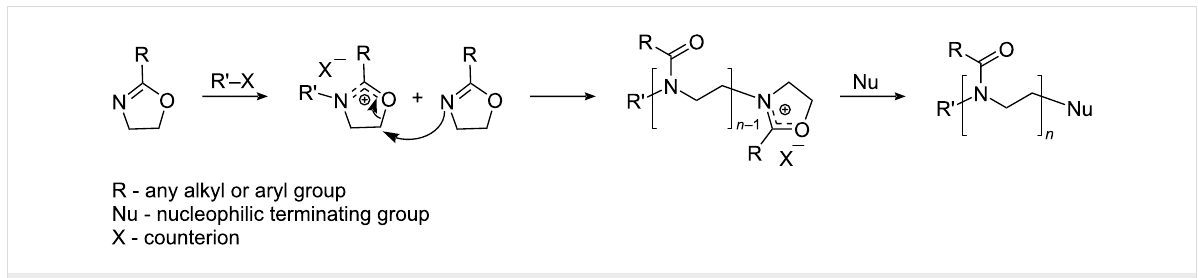
Figure 1: Schematic representation of the mechanism of the cationic ring-opening polymerization (CROP) of 2-alkyl-2-oxazolines.